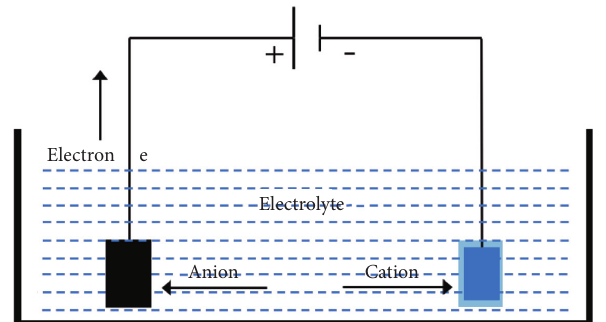
Figure 5: Electropolishing setup.